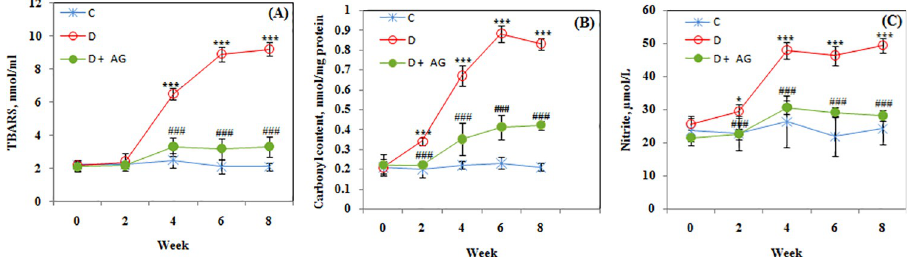
Fig 4. Glycoxidated stress biomarkers of alloxan-diabetic rabbits treated for 8 weeks with aminoguanidine. Levels of TBARS ( A ), Carbonyl ( B ) and nitrite ( C ). Values are mean ± SD, (n = 6 rabbits/group). � , ��� Significant difference (p < 0.01, p < 0.0001) as compare to control. ### Significant difference (p < 0.0001) as compare to diabetic rats.